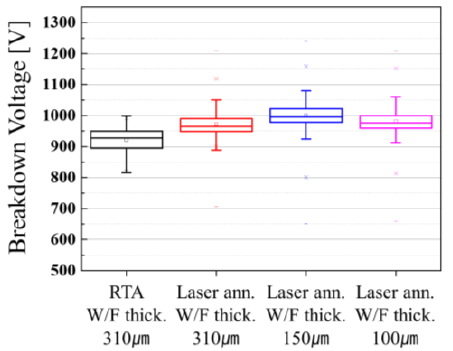
Figure 5. The breakdown voltage properties of fabricated JBS diodes at a current of 250 μ A in TO-220 packages.